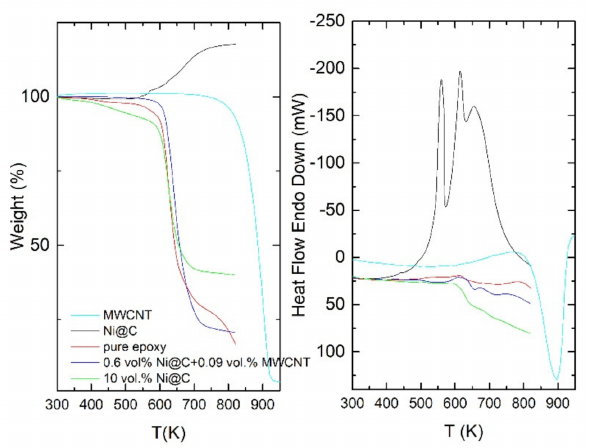
Figure 5. Thermogravimetric analysis of MWCNT, Ni@C nanoparticles, epoxy and composites with these inclusions.